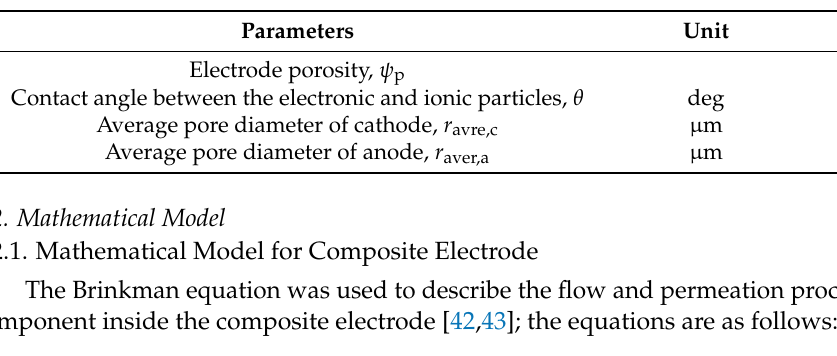
Table 4. Modeling parameters in the mesostructure model